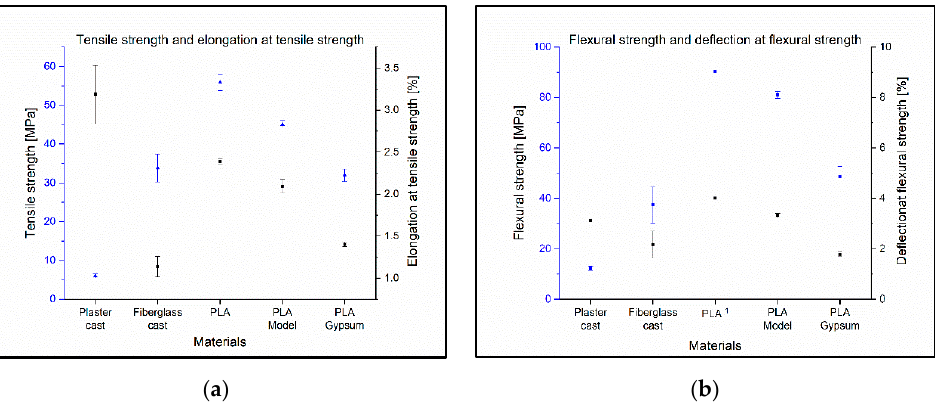
Figure 7. ( a ) Tensile strength and elongation at tensile strength with standard deviations. Blue squares and lines indicate the mean and standard deviation of the tensile strength; black squares show the value of elongation with standard deviation at tensile strength. ( b ) Flexural strength and deflection of flexural strength. The mean of flexural strength with the standard deviation is indicated by the blue squares and line, and the black squares and line refer to the deflection and its standard deviation at flexural strength. 1 In the case of PLA material, only one specimen was broken during the tests.